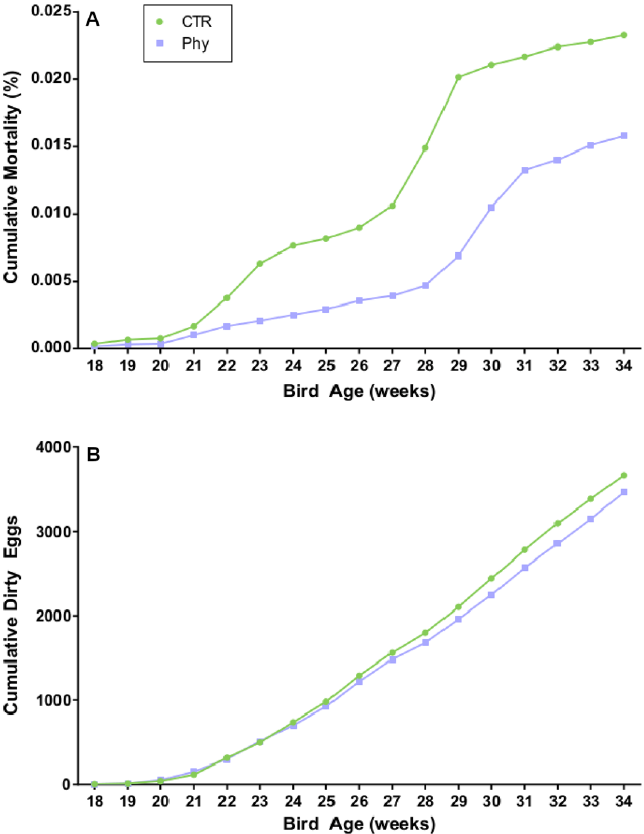
Figure 1. Cumulative mortality and a cumulative number of dirty eggs show a continual trend of improvement in the phytogen supplemented